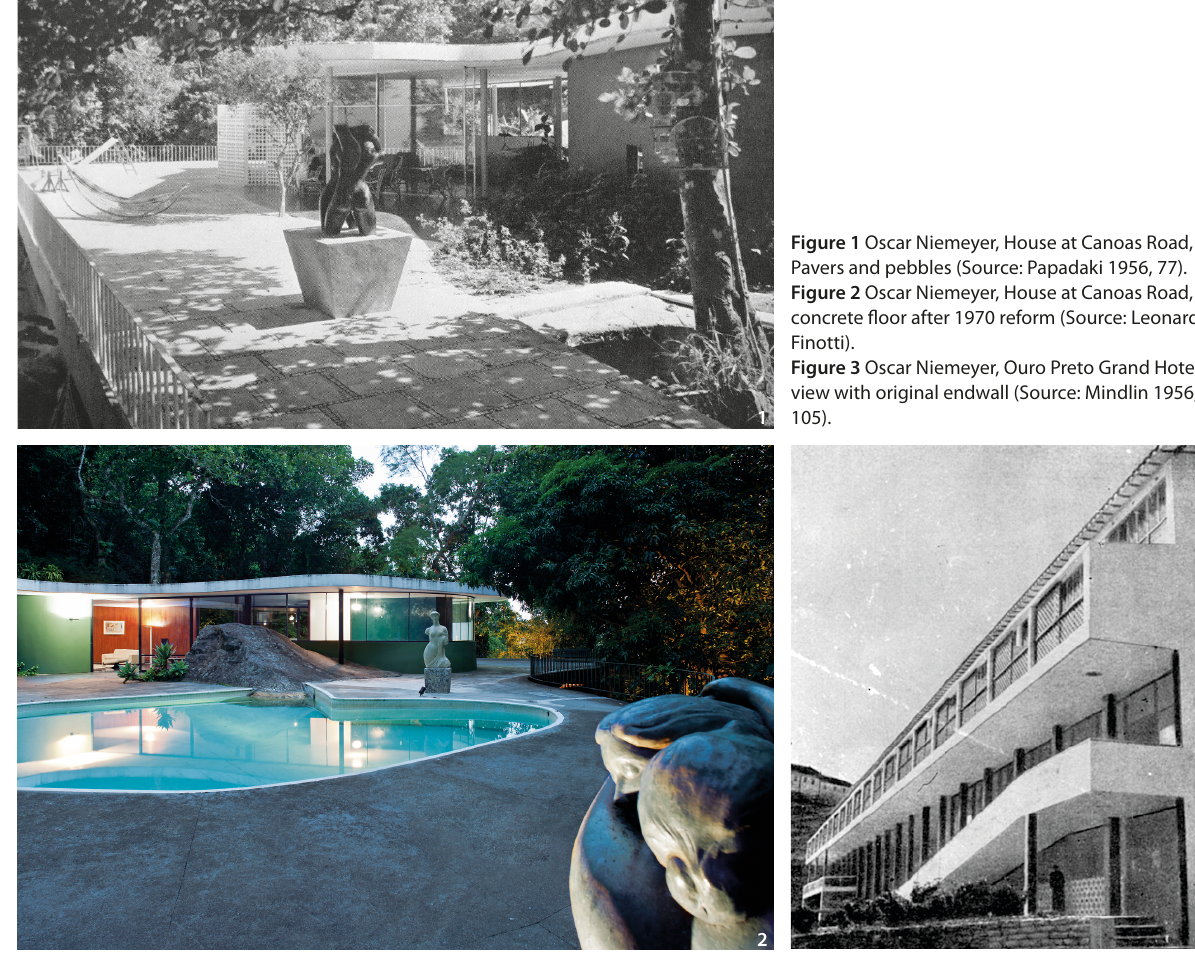
Figure 2 Oscar Niemeyer, House at Canoas Road, concrete floor after 1970 reform (Source: Leonardo Finotti). Figure 3 Oscar Niemeyer, Ouro Preto Grand Hotel, view with original endwall (Source: Mindlin 1956,